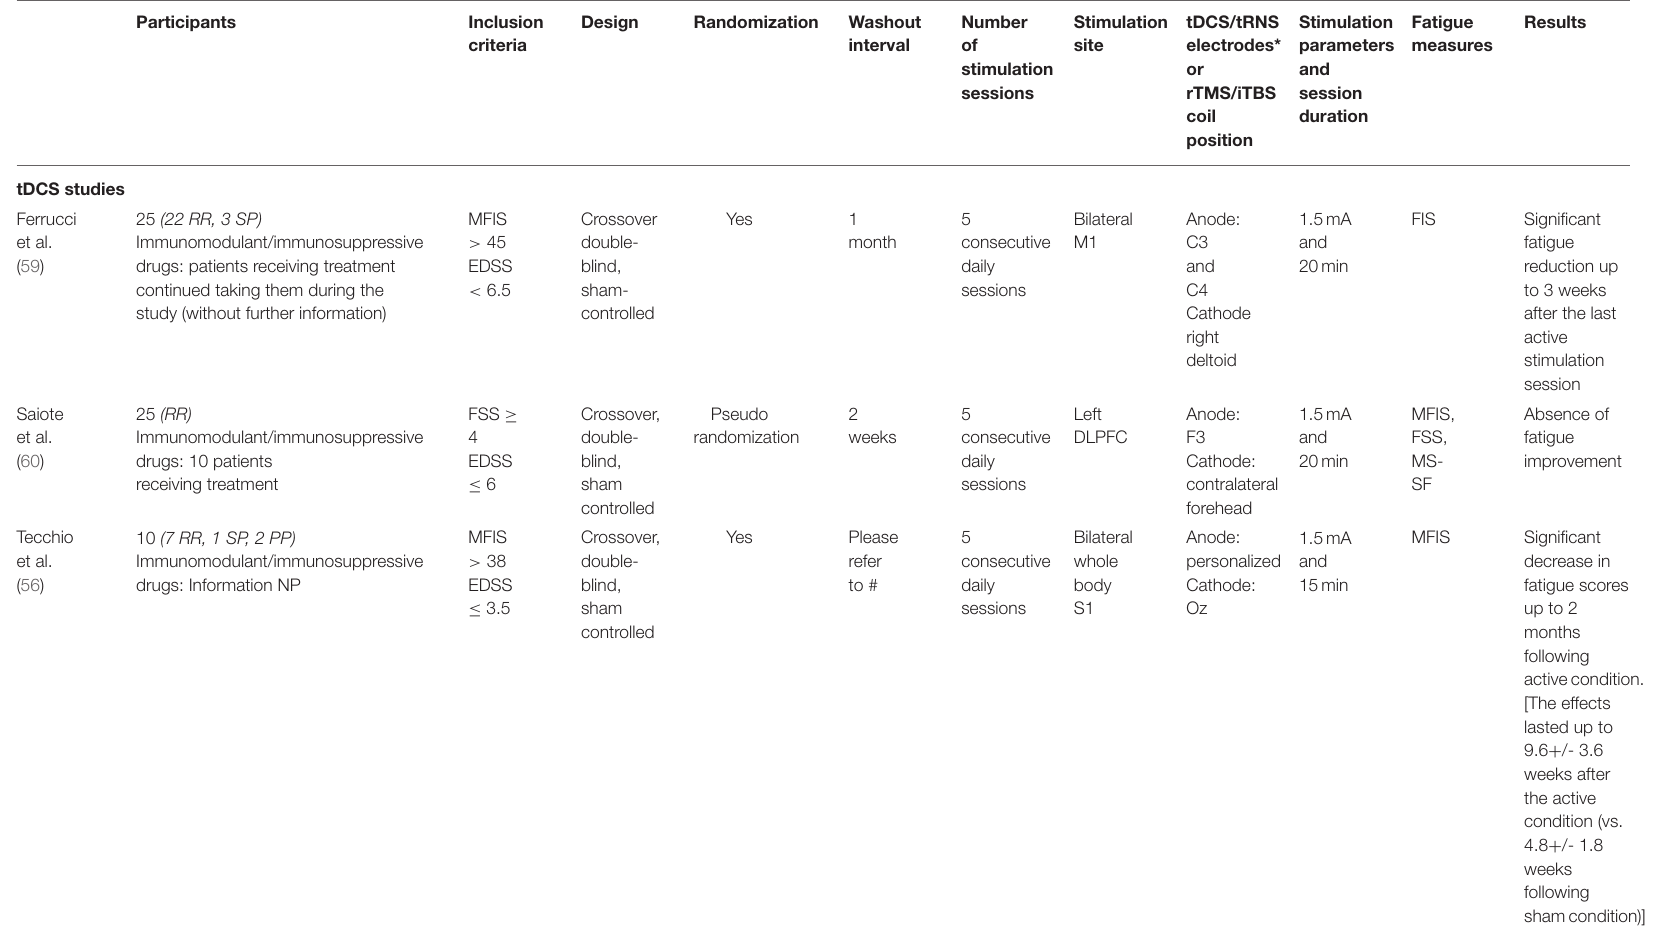
TABLE 2 | Summary of NIBS studies in MS